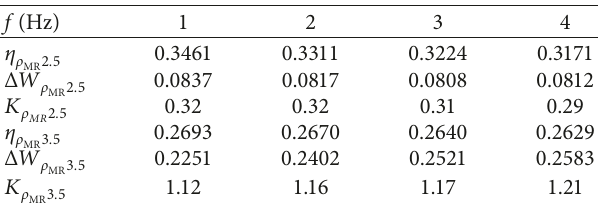
Figure 9: Dynamic hysteresis loop of MR with the density of 3.5 g cm · Table 2: Loss factor, energy dissipation, and dynamic average stiffness